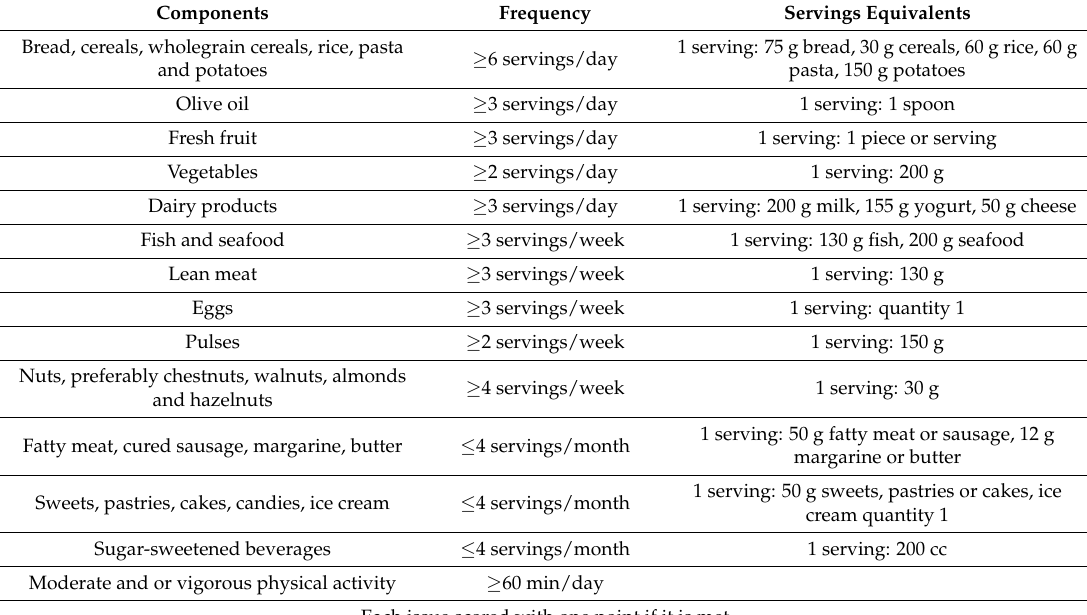
Table 1. Composition of the ATLANTIC diet and lifestyle